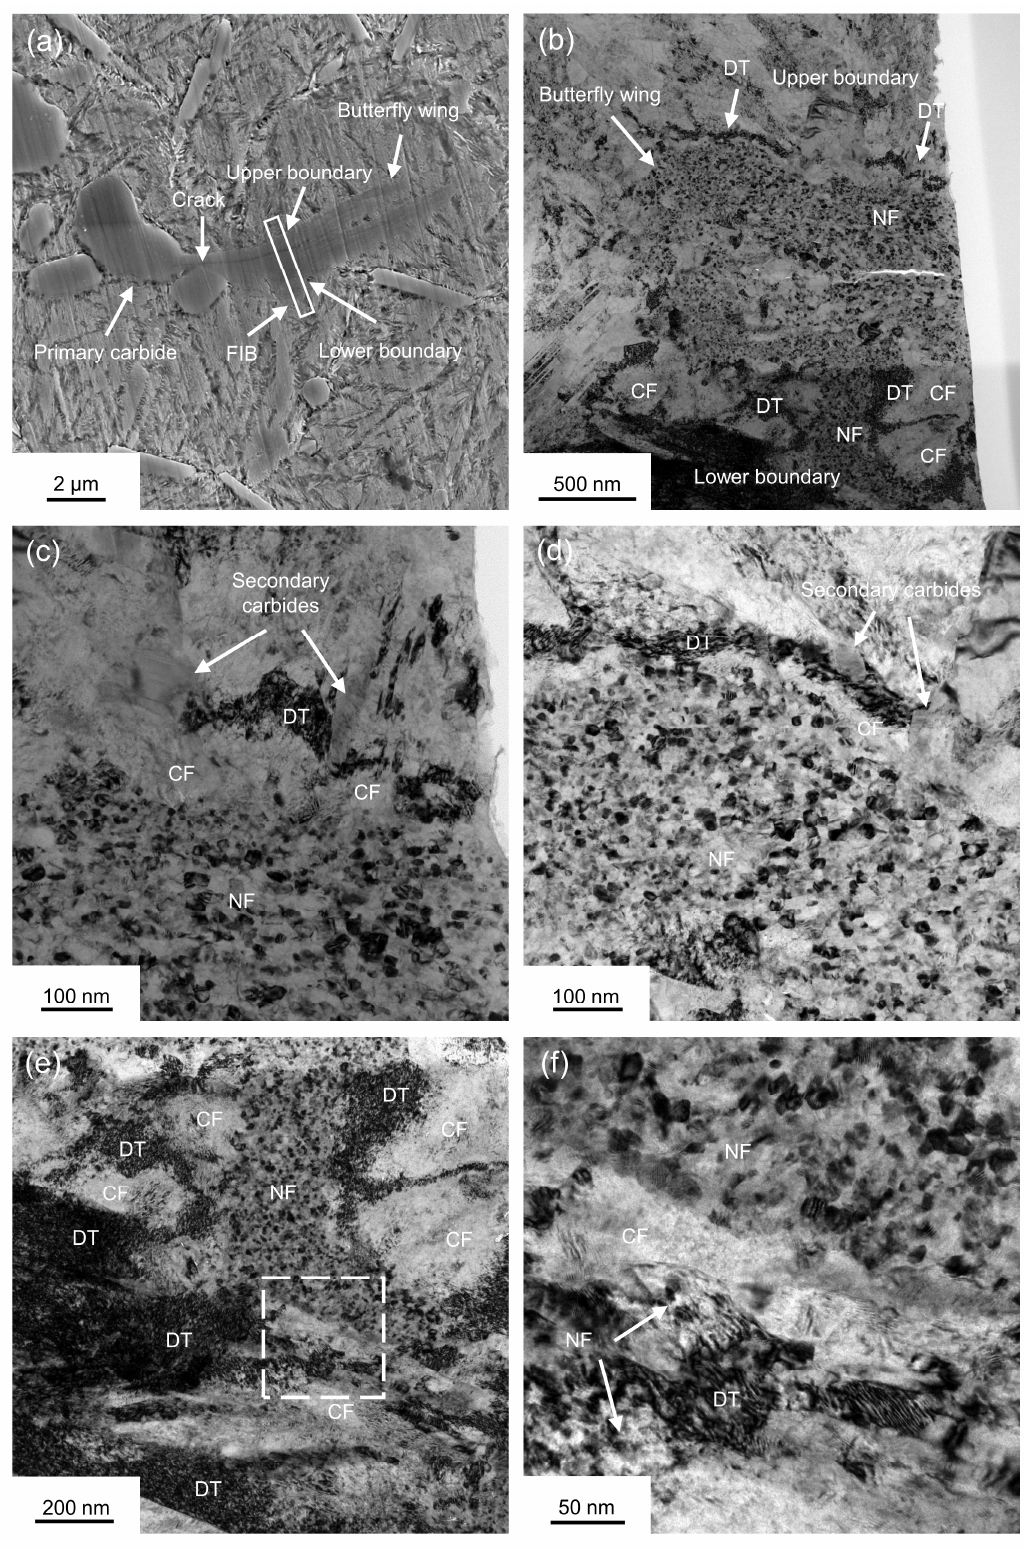
Figure 9. Microstructure observation of the bu tt er fl y wing in the RCF sample ( P 0 = 5 GPa, N = 2.12 × 10 8 cycles): ( a ) SEM micrograph of bu tt er fl y wing and the position of the TEM specimen prepared using FIB; ( b ) TEM micrograph of the bu tt er fl y wing; ( c , d ) TEM micrographs at higher magni fi cation of the upper boundary of a bu tt er fl y wing; ( e ) TEM micrograph at higher magni fi cation of the lower boundary of a bu tt er fl y wing; ( f ) TEM micrograph of the highlighted area in ( e ).